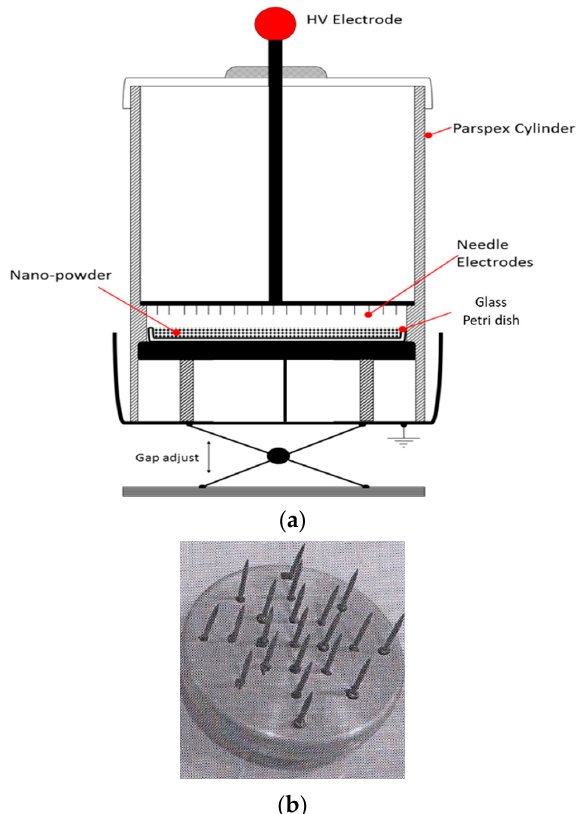
Figure 2. ( a ) Designed outline of Plasma reactor ( b ) High voltage electrode with an array of embedded steel needles.